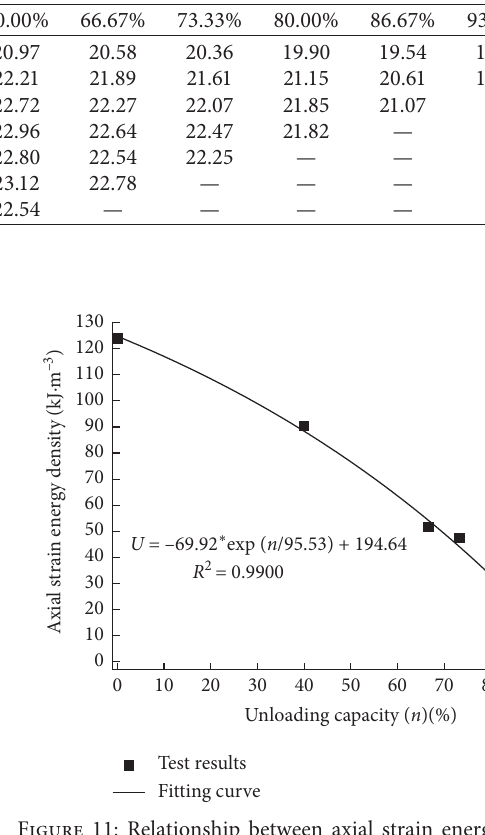
Figure 10: Stress-strain curve of rock.